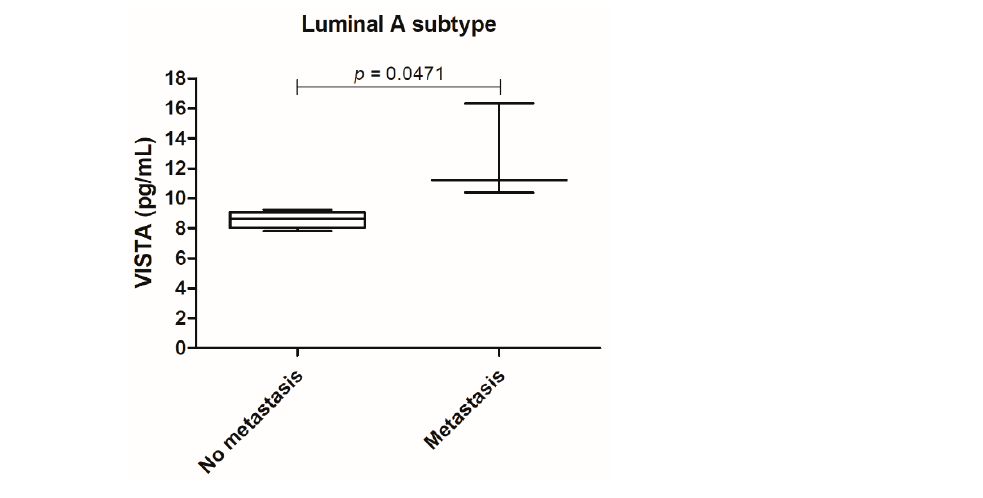
Figure 2. In the luminal A tumor subtype serum VISTA levels were higher in cats presenting metastasis (* p = 0.0471).